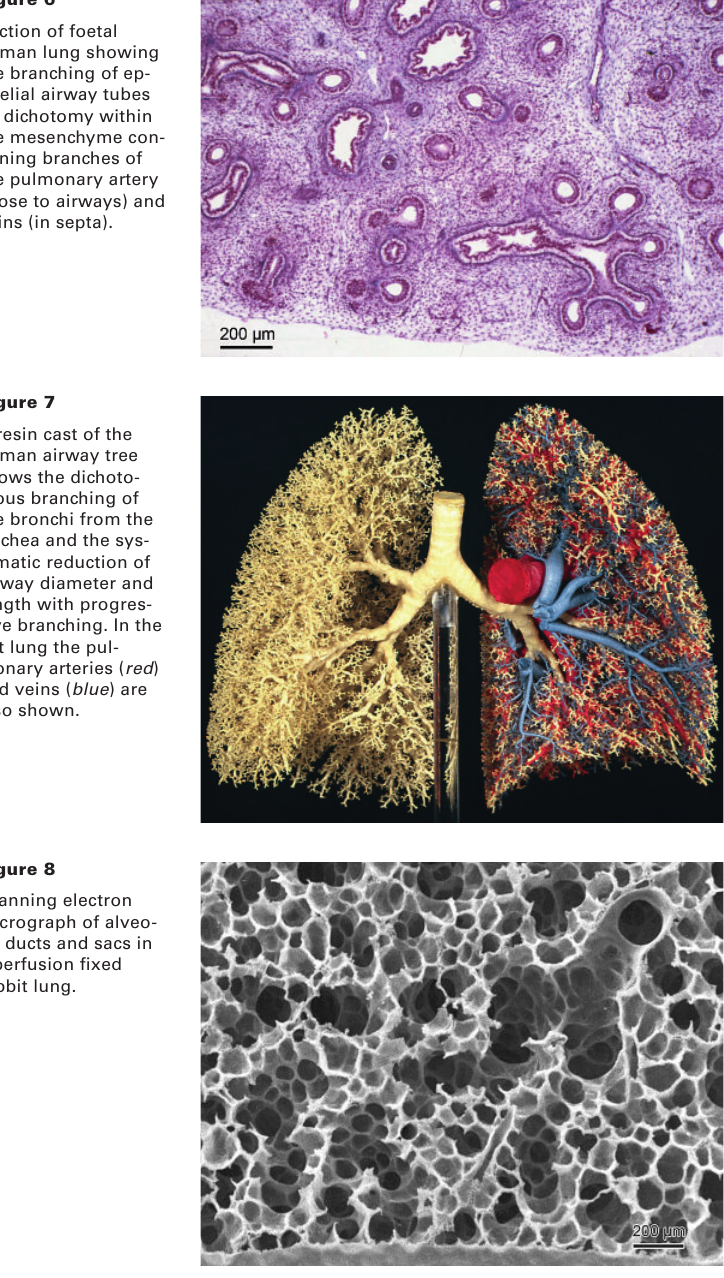
Scanning electron micrograph of alveo- lar ducts and sacs in a perfusion fixed rabbit